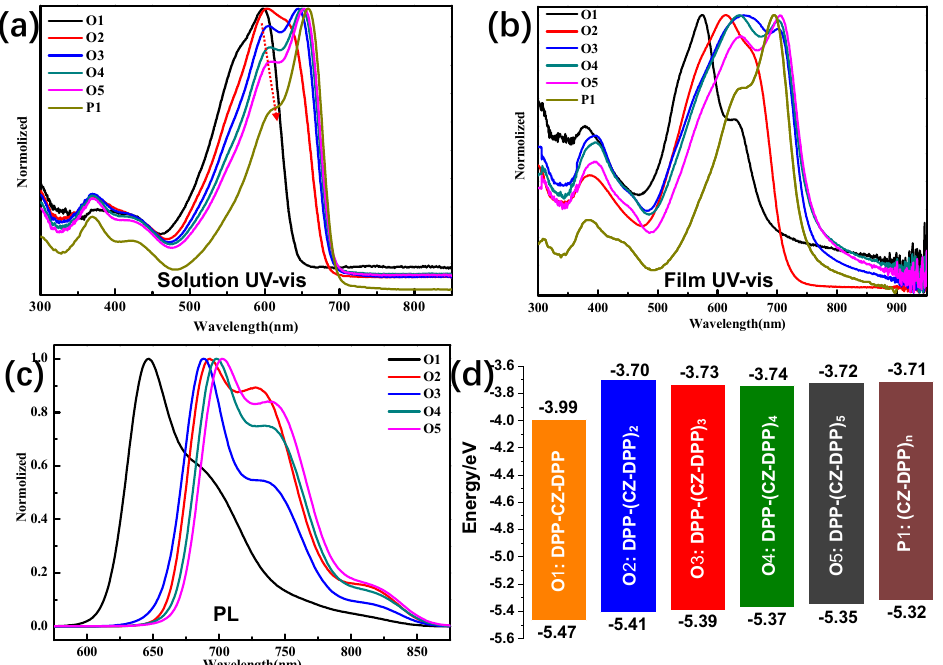
Figure 2. UV-vis absorption spectra of π -COs and P 1 in CF solutions ( a ) and thin solid films ( b ); PL spectra ( c ) and HOMO/LUMO levels alignment ( d ) of π -COs and P 1. Table 1. Key opto-electrochemical property data of O s1~5 and P 1. The maximum absorption peaks of O s1~5 and P 1 in solutions ( λ maxs ) are located at 598, 603, 645, 650, 652.5 and 658 nm, respectively. The red-shifts of O s2~5 and P 1 compared to O 1 are 5, 47, 52, 54.5 and 60 nm, respectively, as a result of the increase of π -conjugation length. Corresponding to the gradual red-shifts of light absorption, the colors of O s1~5 and P 1 solutions evolved from purple, blue-purple, blue, blue-green to green (Scheme 1). The extinction coefficients ( ε ) of O s1~5 solutions at λ maxs are 6.3 × 10 4 , 1.2 × 10 5 , 1.9 × 10 5 , 2.8 × 10 5 and 3.8 × 10 5 M − 1 · cm − 1 respectively, showing a near linear-correlation